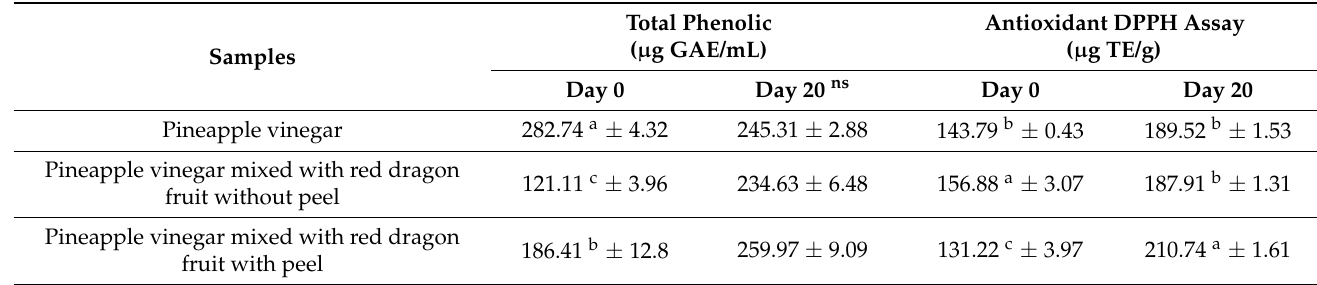
Table 3. Total phenolic compound and antioxidant activity of the fruit vinegar